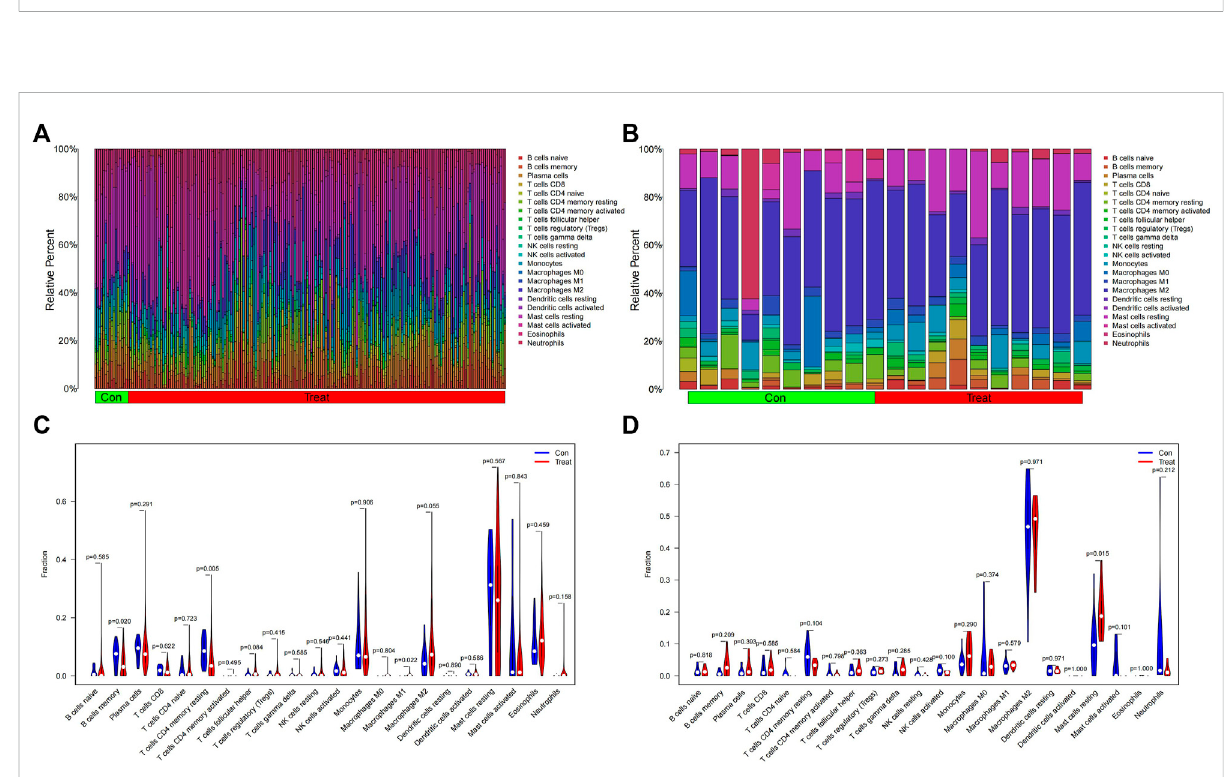
FIGURE 9 Immune cell in fi ltration analysis. (A,B) Relative number of immune cells; (C,D) Analysis of the difference in the relative number of immune